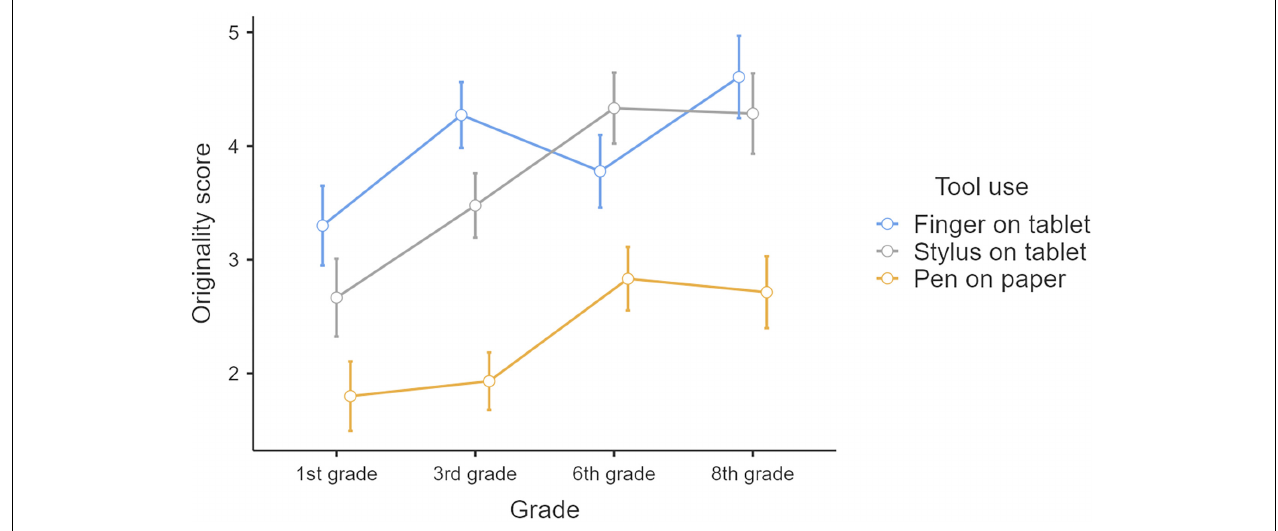
FIGURE 6 | Originality scores (mean and standard errors of mean) according to the tool used and grade.